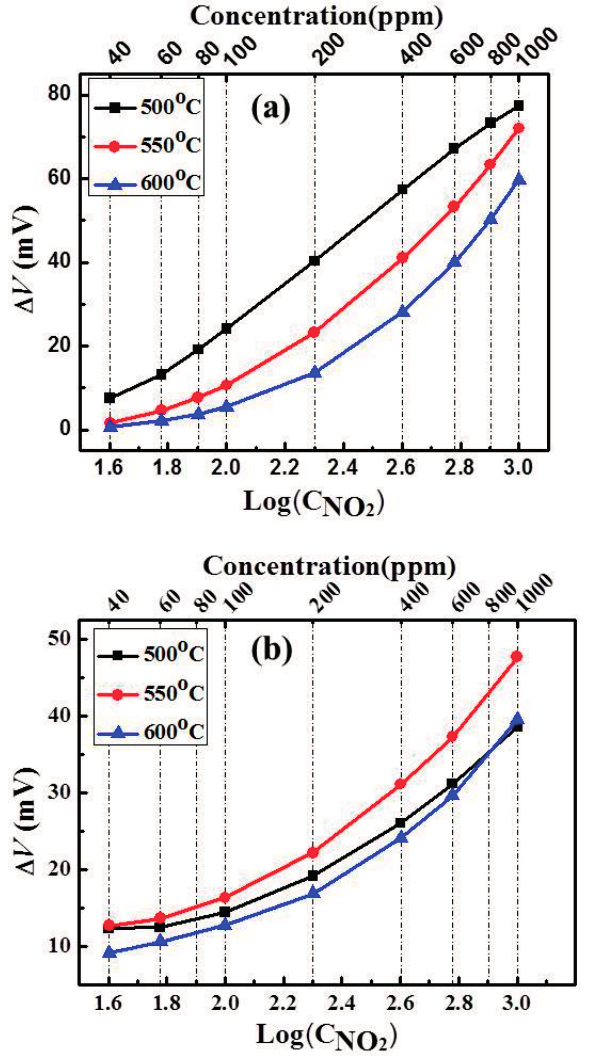
Figure 11. Dependence of response voltages on logarithm NO 2 concentrations in the sample gas at 500–600 °C for the sensors: ( a ) S-LSM95 and ( b )